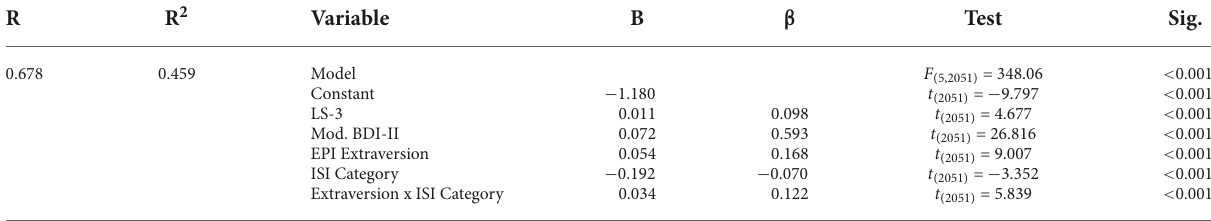
TABLE 1 Results of hierarchical linear regression predicting the combined suicidal ideation score from trait extraversion and insomnia category . R R 2 Variable B β